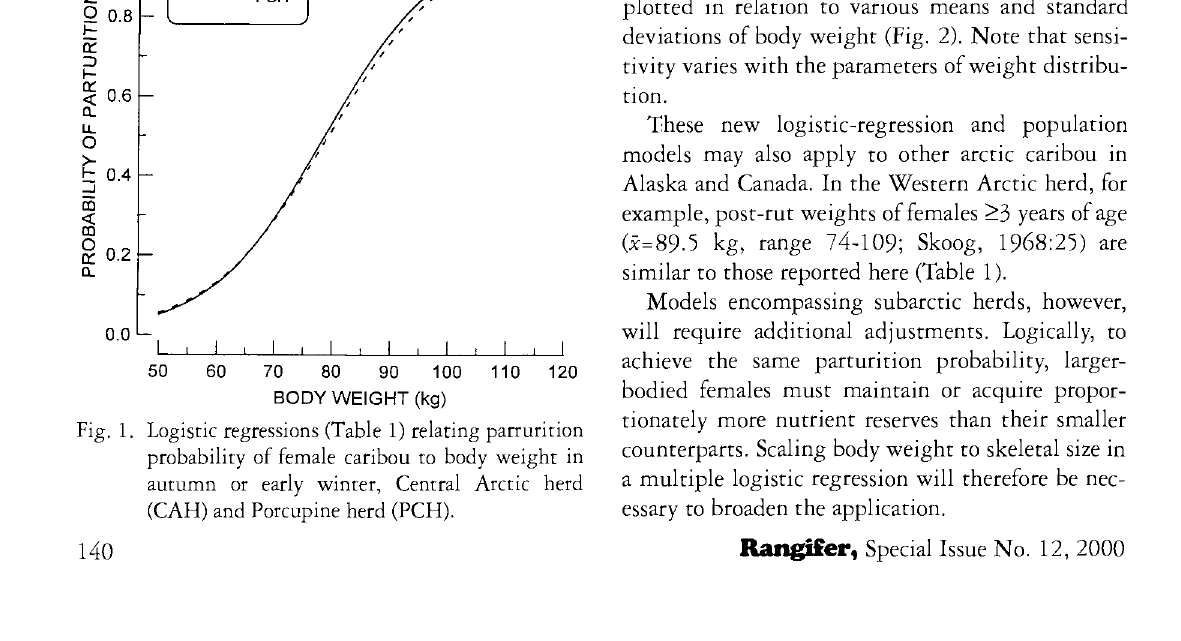
Fig. 1. Logistic regressions (Table 1) relating parrurition probability of female caribou to body weight in autumn or early winter, Central Arctic herd (CAH) and Porcupine herd